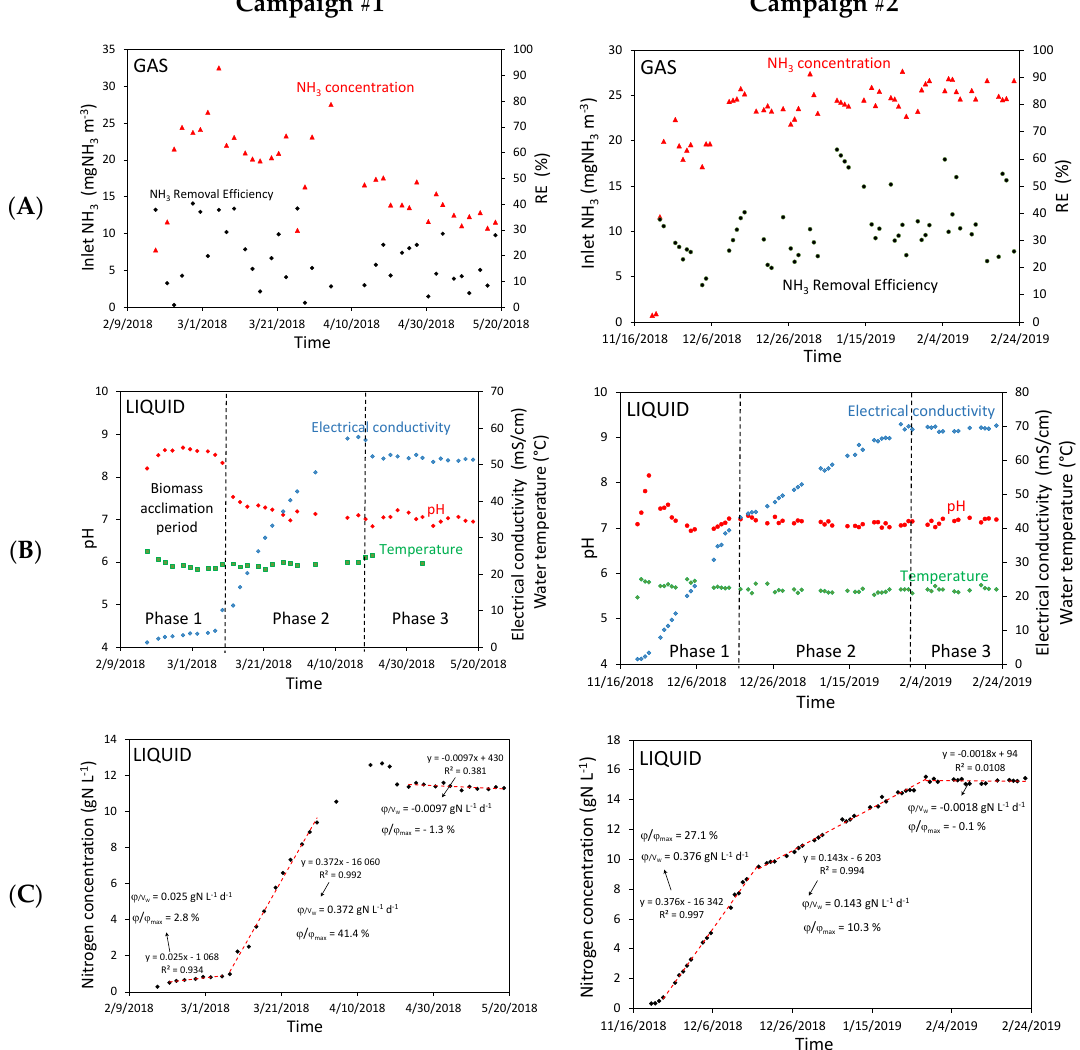
Figure 3. Experiment results recorded for campaigns #1 and #2. ( A ) Ammonia concentration in the air entering the biotrickling filter and ammonia removal efficiency determined from measurement in the gas phase; ( B ) Parameters measured for the scrubbing liquid in the buffer tank (temperature, pH and electrical conductivity); ( C ) Total nitrogen concentration in the scrubbing liquid deduced from the electrical conductivity measurement (Equation (6)).